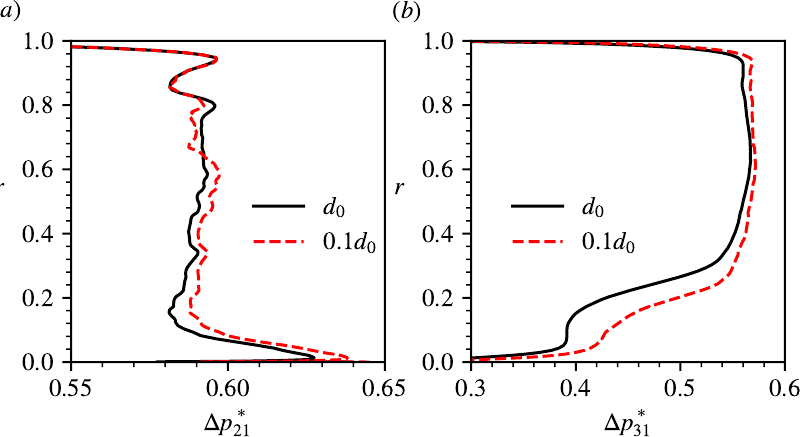
Figure 14. Spanwise distributions of the total pressure rise on ( a ) the rotor and ( b ) the stator outlets. On the stator outlet, with the gap reduced to 0.1 d 0 , the total pressure rise was